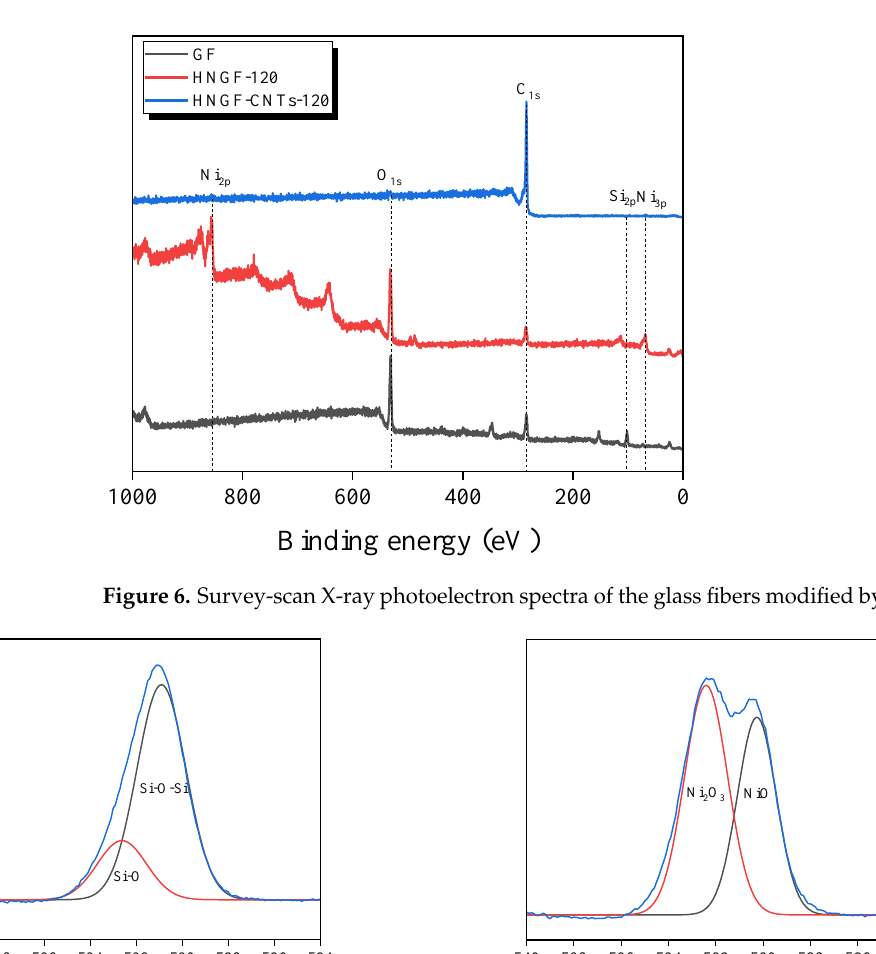
Figure 6. Survey-scan X-ray photoelectron spectra of the glass fibers modified by different treat- ments.